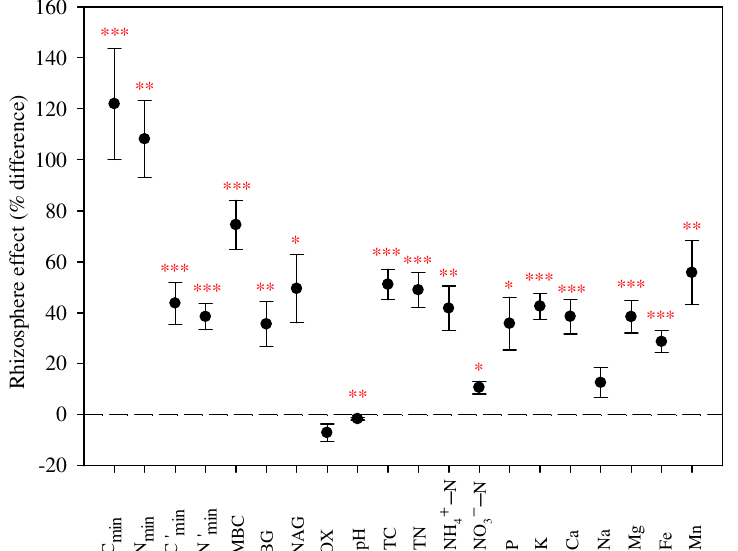
Figure 1. The means of rhizosphere effects on given variables, including soil carbon mineralization rate per gram soil (C min ), net nitrogen mineralization rate per gram soil (N min ), carbon mineralization rate per gram soil total carbon (C′ min ), net nitrogen mineralization rate per soil total nitrogen (N′ min ), microbial biomass carbon (MBC), β −glucosidase (BG), N−acetyl− β −glucosaminidase (NAG), oxidase (OX), pH, total carbon (TC), total nitrogen (TN), ammonium nitrogen (NH + 4 −N), nitrate nitrogen (NO － 4 −N), extractable phosphorous (P), extractable potassium kalium (K), extractable calcium (Ca), extractable natrium (Na), extractable magnesium (Mg), extractable ferrum (Fe), and manganese (Mn). Values are the means and error bars are the standard errors of the eleven altitudinal sites. Asterisks indicate significant differences between rhizosphere soil and bulk soil based on paired-samples t -tests (* p < 0.05, ** p < 0.01, *** p < 0.001).